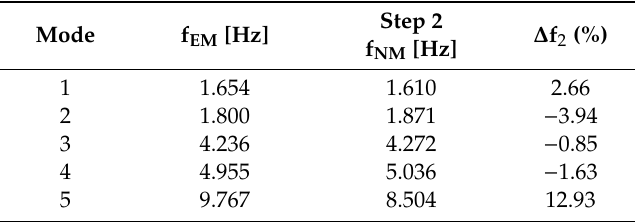
Table 3. Comparison between EM and NM frequencies at step